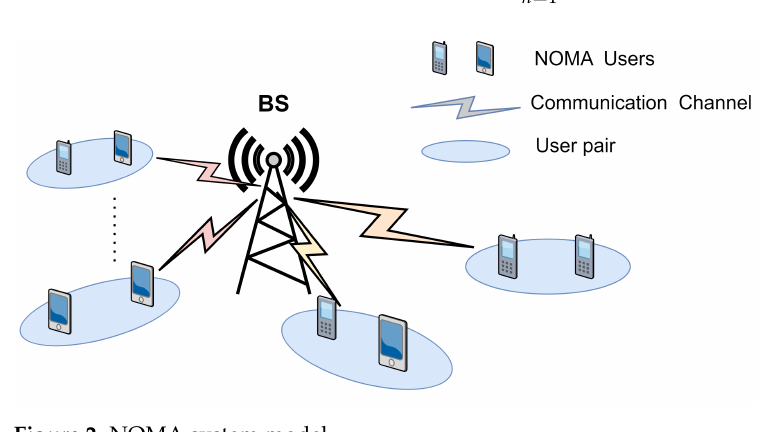
Figure 2. NOMA system model.